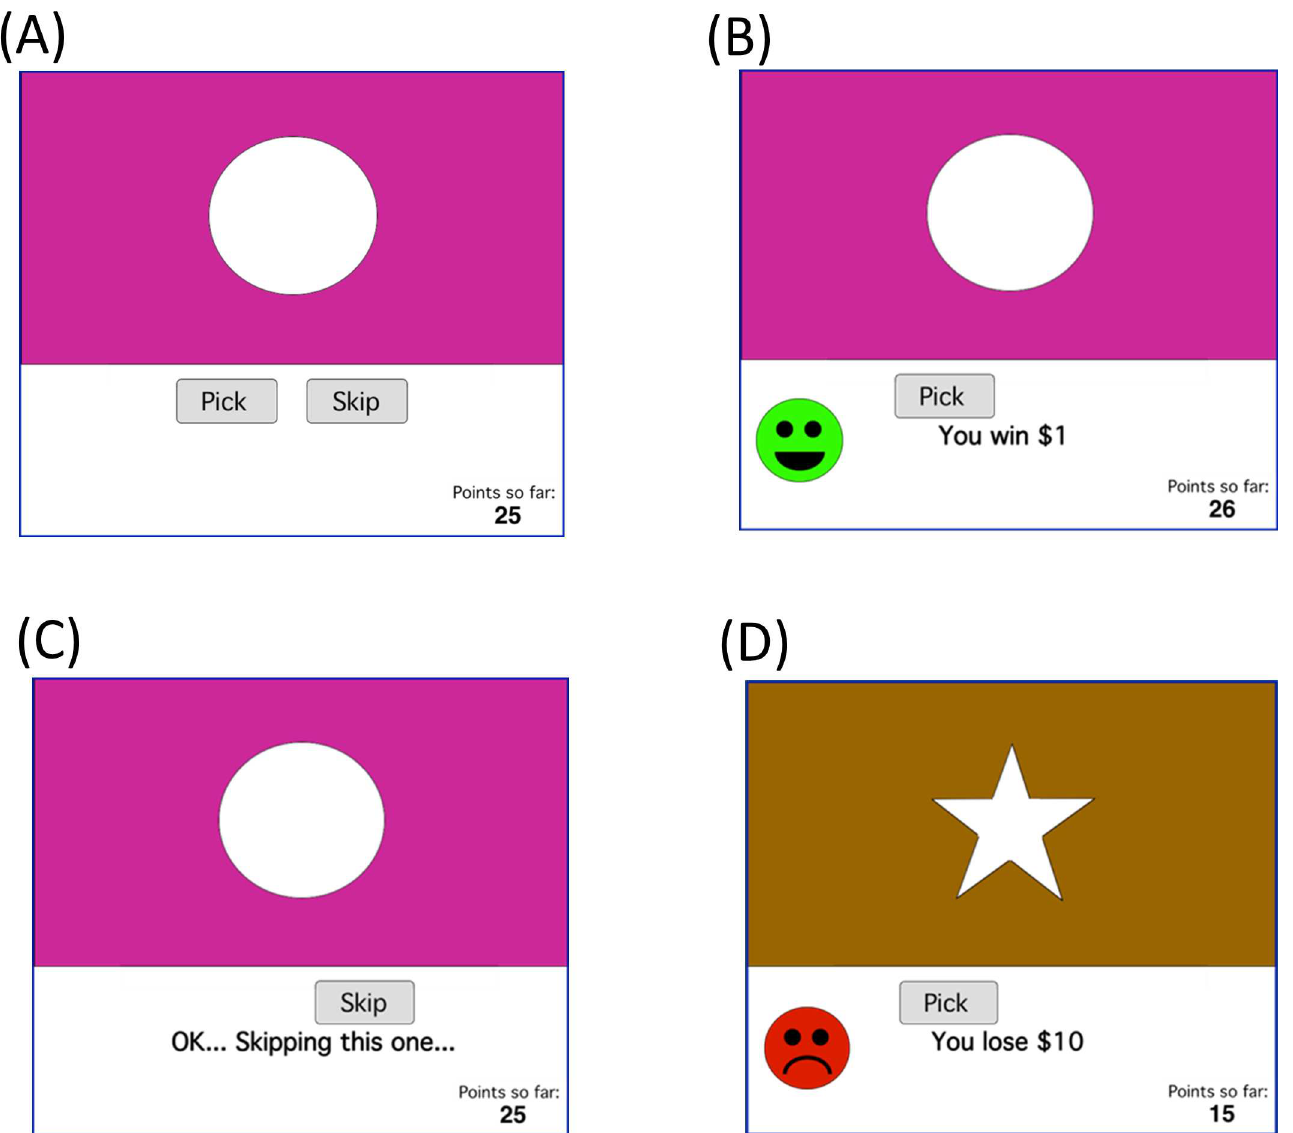
Fig 1. Example screen events during the training phase. (A) At the start of a trial, the screen shows one of four stimuli, each composed of a white geometric shapepresentedagainsta colored background. The subject was promptedto “pick” or “skip” this stimulus by using the mouse to click on the on-screen buttons. (B) On reward-based trials, a positively-valencedstimulus was presented, and a “pick” responseresulted in positive feedbackand point gain; (C) a “skip” responseresulted in no point gain (or loss). (D) On punishment-based trials, a negatively-valencedstimulus was presented, and a “pick” responseresulted in negativefeedbackand point loss, while a “skip” response resultedin no point change.